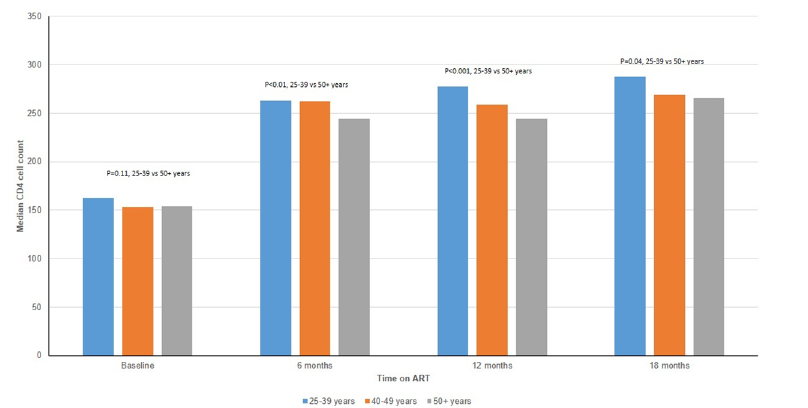
Fig 2. Median CD4 count by age at antiretroviral therapy (ART) and duration on ART.